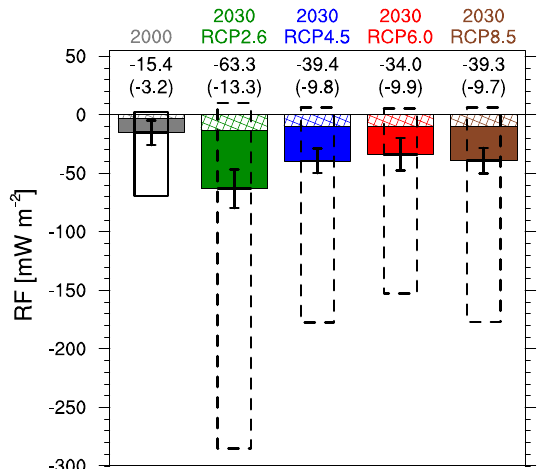
Figure 8. Global mean all-sky RF resulting from aviation emissions in the year 2000 (grey bar) and for the four RCP scenarios in 2030 (coloured bars). The hatched part of each bar is the correspond- ing clear-sky forcing, calculated neglecting the radiative effects of clouds. The numerical values of the all-sky (clear-sky) forcing are shown on top of each bar in units of mWm − 2 . The whiskers rep- resent the 95% confidence interval with respect to the interannual variability. The boxes correspond to the uncertainty range derived from the assumption on the size distribution of emitted particles and fuel sulfur content, as calculated by R13 for the year 2000 (solid) and rescaled here to the 2030 values